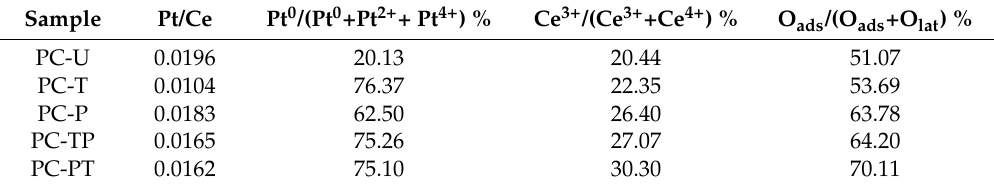
Figure 5. XPS spectra for different Pt/CeO 2 samples: ( A ) Ce 3d, ( B ) O 1s, ( C ) Pt 4f. Table 3. XPS data of various samples.